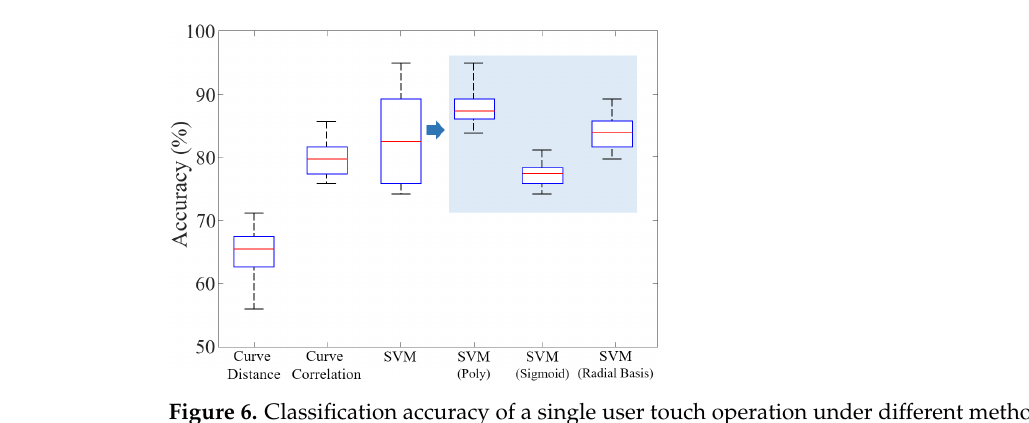
Figure 6. Classification accuracy of a single user touch operation under different methods. It can be clearly seen that the SVM with poly-function does the best, which we choose in BioTouch for user feature